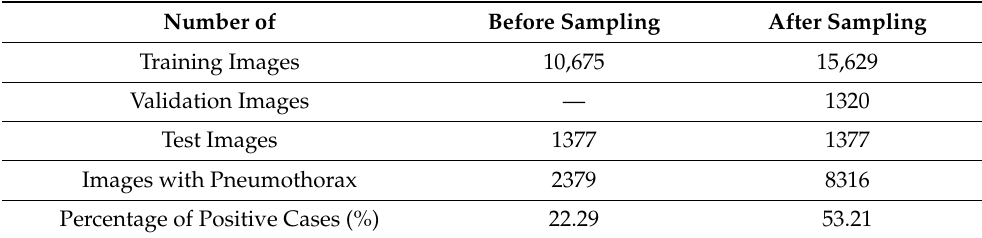
Table 3. Training, validation, and testing dataset (split). Number of After Sampling